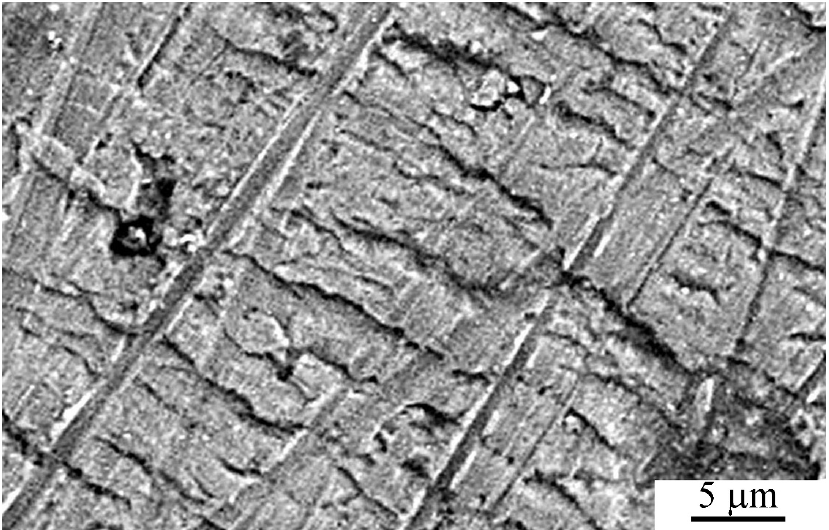
Figure 18. SEM image of the surface of deformed Al87Ni8La5 alloy [reproduced from Mater. Let. 2019, 252, 114 with permission from Elsevier, 2020] [128].